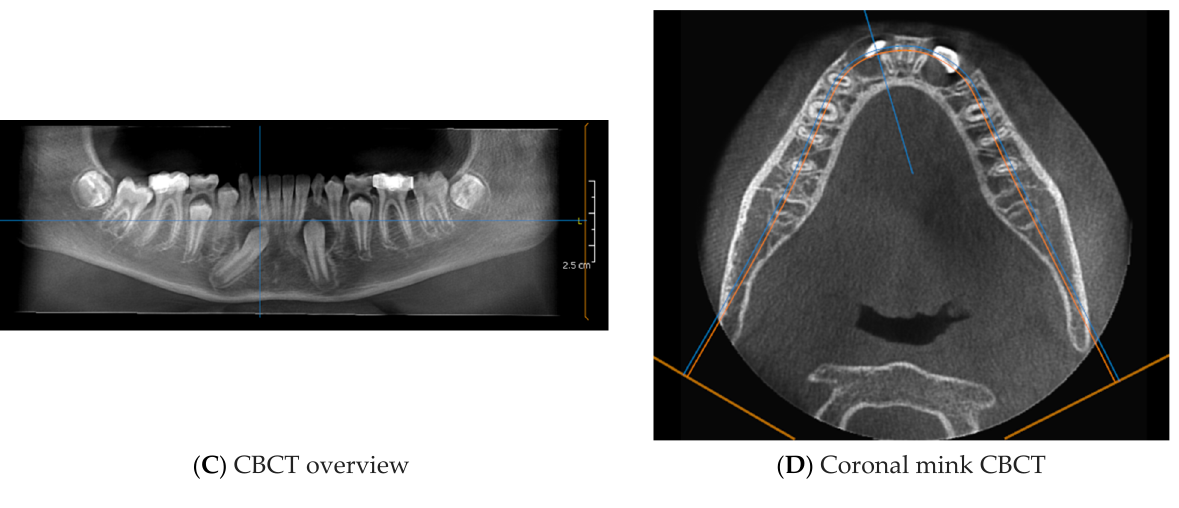
Figure 9. CBCT of the IMC (( A ) + ( B ) + ( C ) + ( D )). The CBCT showed part of the crown of the IMC (4.3) in contact with the root apices of the right lower incisors. (4.1 and 4.2).